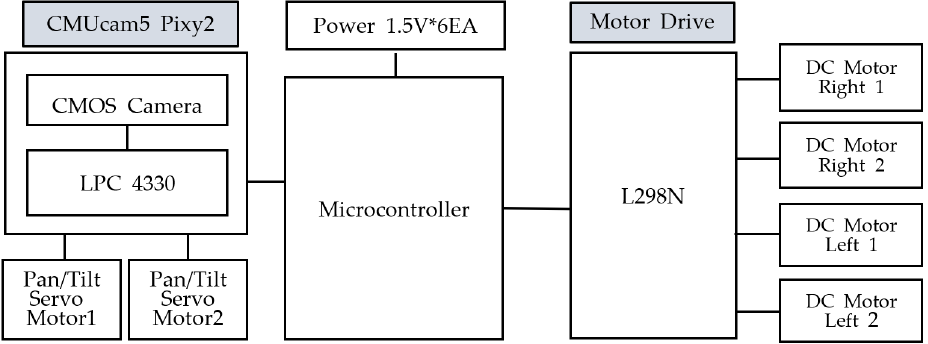
Figure 1. Block diagram of the configuration of the AGVA-Robot. Schematics follow the same formatting.